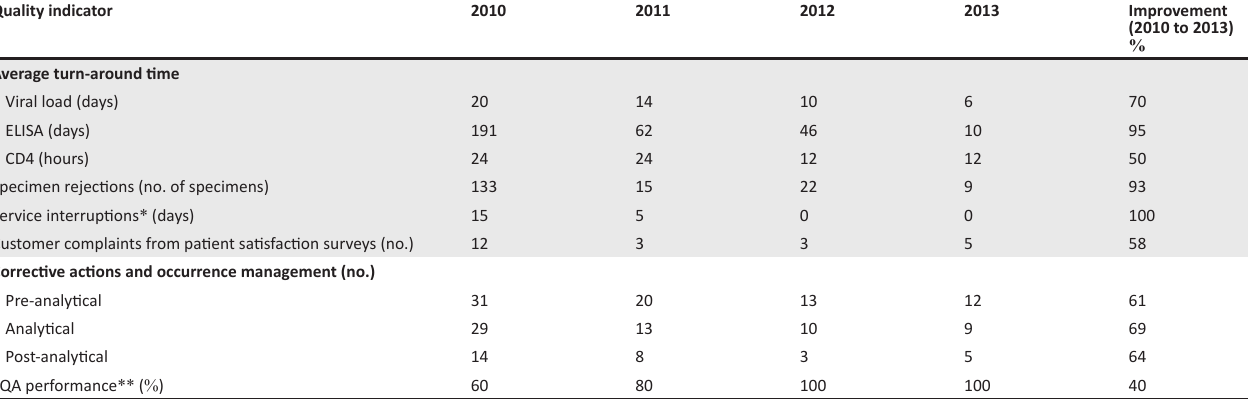
TABLE 2: Trends in quality indicators, Kenya’s National HIV Reference Laboratory, 2010–2013. Quality indicator